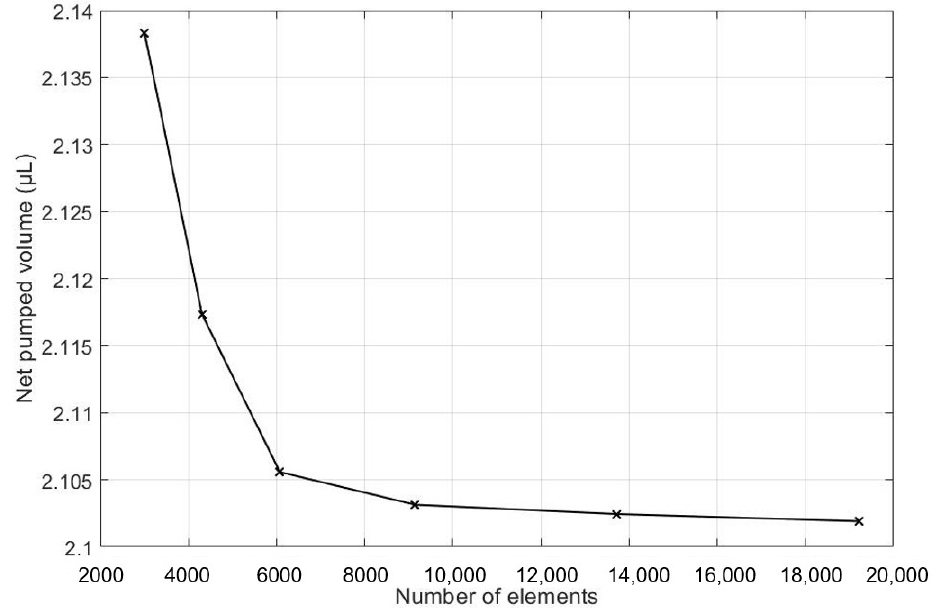
Figure 6. Net volume pumped is calculated for different numbers of elements.